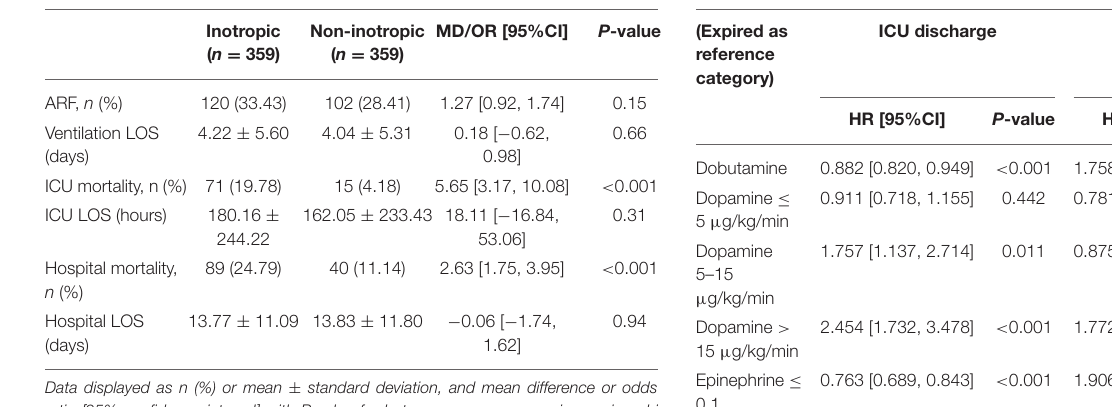
TABLE 5 | ICU and hospital mortality risk analysis in the patients with cardiogenic shock receiving different inotropic